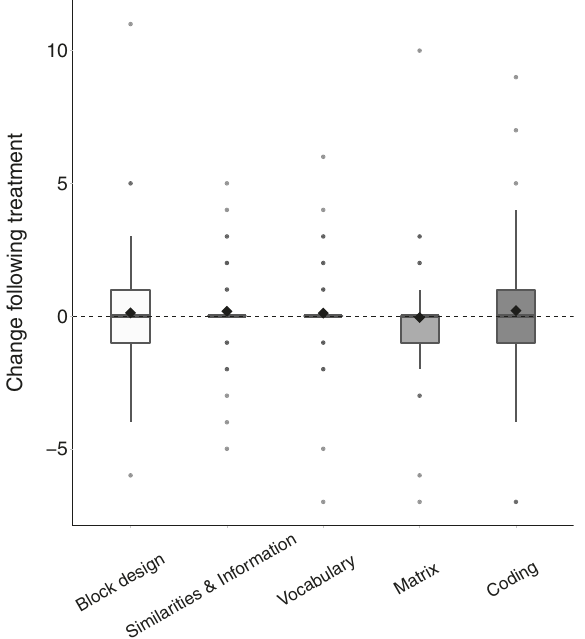
Fig. 5 Change in cognitive sub-test scores pre/post treatment. Block design perceptual test, matrix perceptual test, vocabulary verbal test, similarities & information verbal test, coding processing speed test. Asterisk: signi fi cant change ( p < 0.05, randomization test). Black diamond: mean. Bold line: